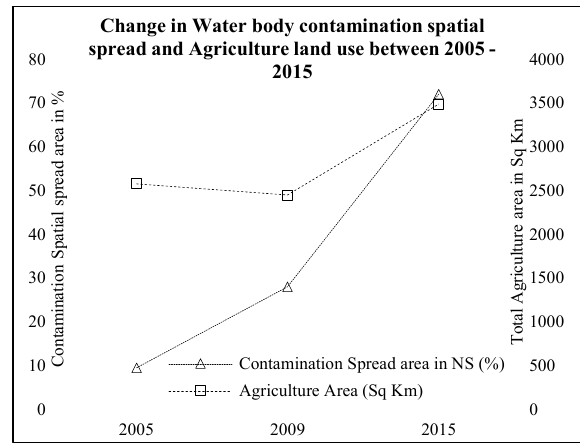
Figure 12. Shows the changes occurring in contamination spatial spread area in NS along with the agriculture land use area in NS watershed from 2005 –